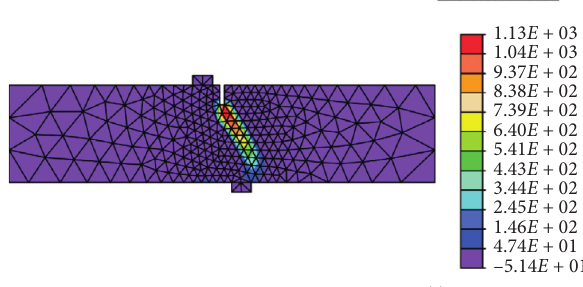
Figure 20: Principal stress σ I , with elastic unloading of the bulk.